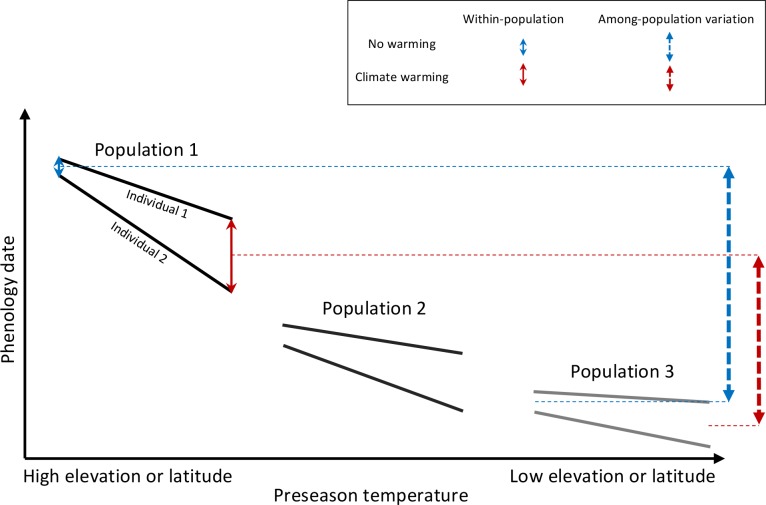
Schematic representation of within- and among-population phenological synchrony in response to climate warming.As demonstrated in this study, inter-individual synchrony within a population will decrease under warmer preseason temperatures because individuals differ in their sensitivity to temperature. Within-population variation under ambient or warmed preseason temperatures is illustrated by the solid blue and red arrows, respectively. By contrast, phenological synchrony among populations is expected to increase, given that populations in warm regions (Population 3) will advance their phenology less than populations in cold regions (Population 1). This is illustrated by the dashed blue and red arrows, showing that the difference in the average phenological date between Population 1 and 3 is smaller under warmer preseasons (red dashed arrow) than under ambient preseason temperatures (blue dashed arrow).